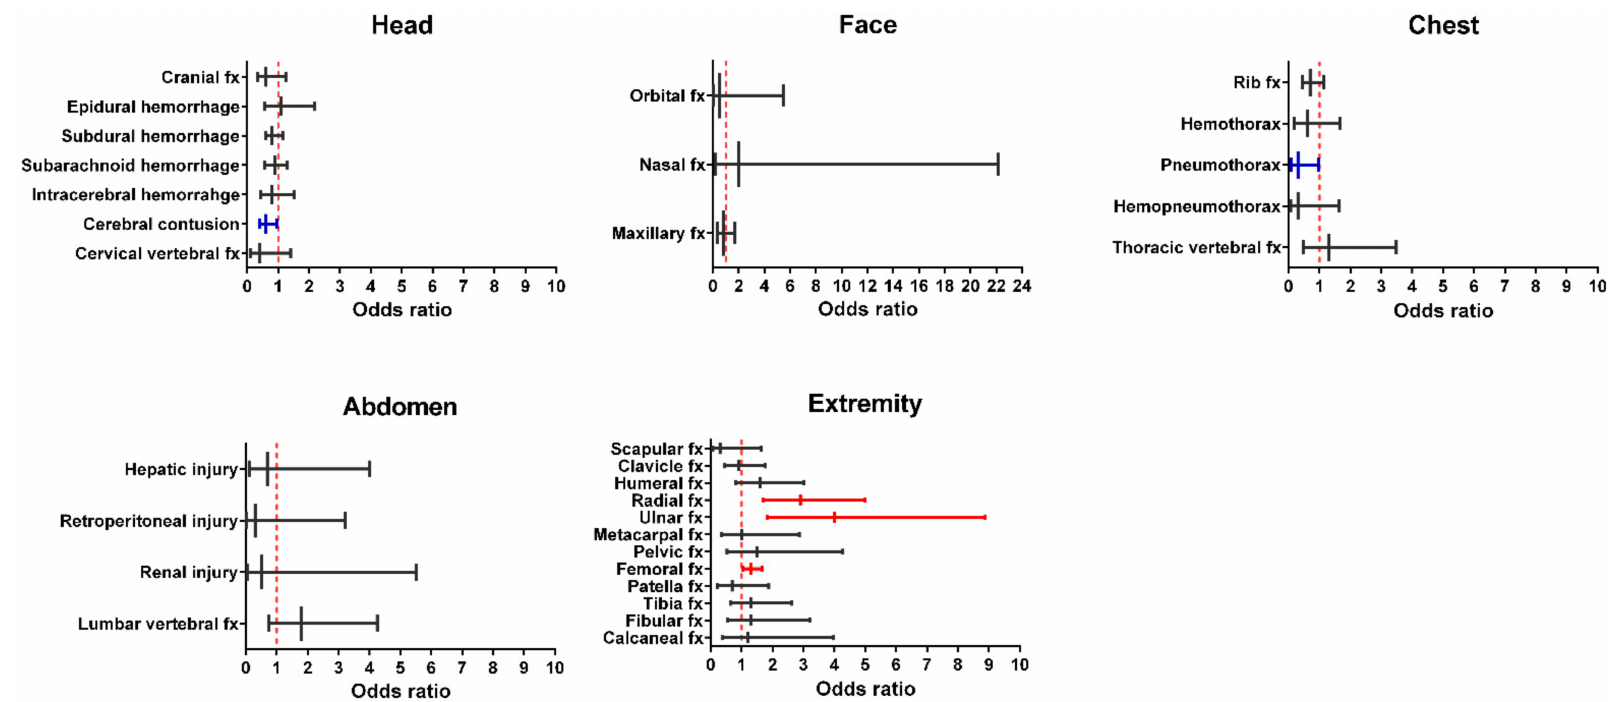
Figure 3. Odds of associated illness between the propensity-score matched female and male patients with high-risk OSTA score. fx =